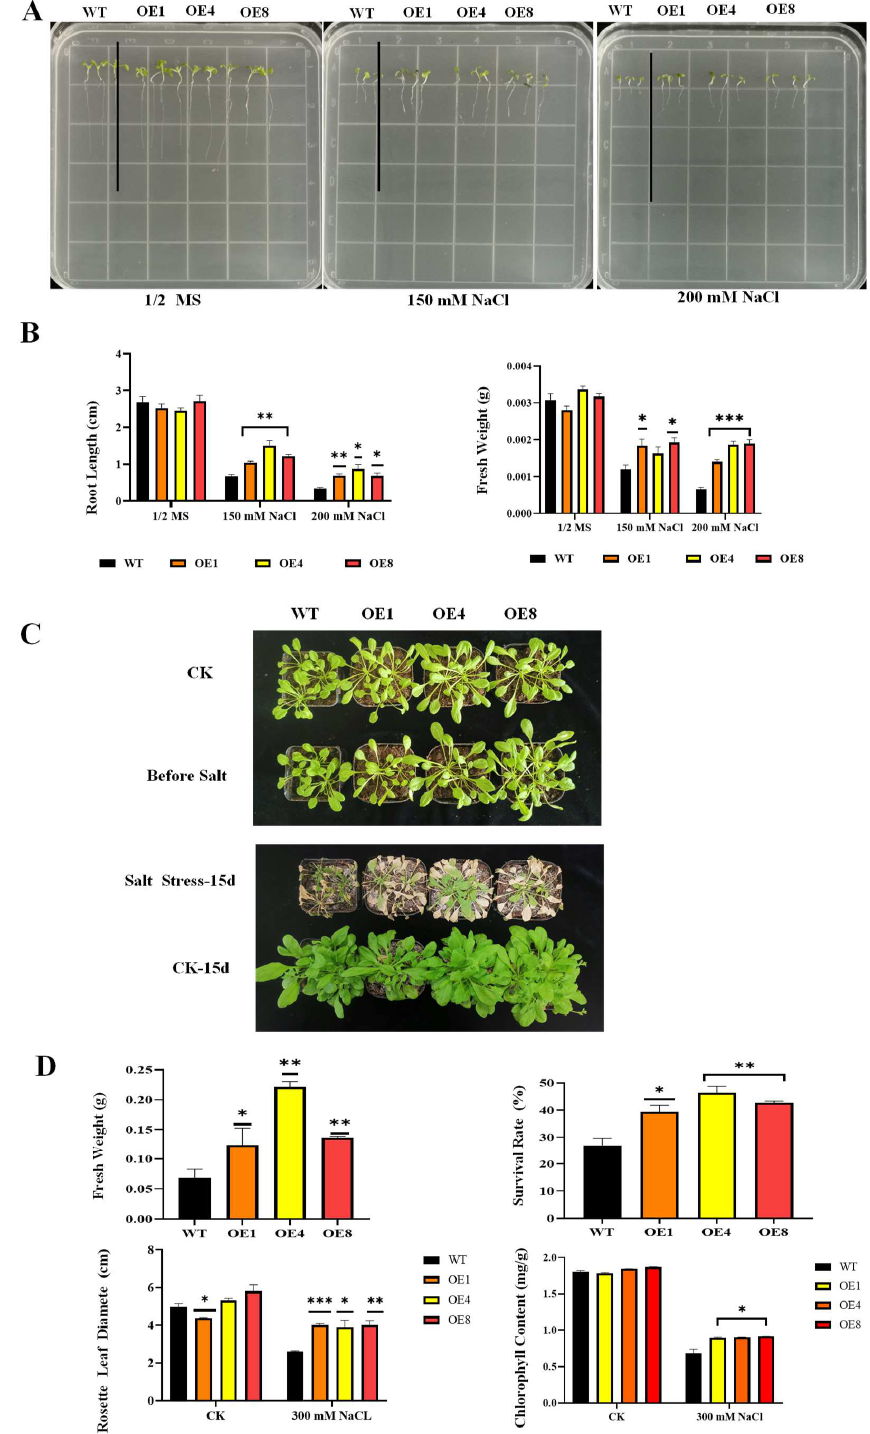
Figure 4. Overexpression of PcWRKY11 in A. thaliana improved salt tolerance. ( A ) Transgenic and wild-type plants grown on 1/2 × MS medium with different NaCl concentrations. ( B ) Graphical representation of the root length and fresh weight in ( A ). ( C ) Phenotype of 4-week-old transgenic and wild-type plants after salt treatment (300 mM NaCl, 15 days). ( D ) Statistical analysis of the rosette leaf diameter, fresh weight, survival rate, and chlorophyll content in ( C ). The mean values and standard errors were calculated with three independent experiments. *, **, and *** represent significance level of p < 0.05, p < 0.01, and p < 0.001, respectively; WT, wild-type plants; OE, overexpressed plants; CK, under normal